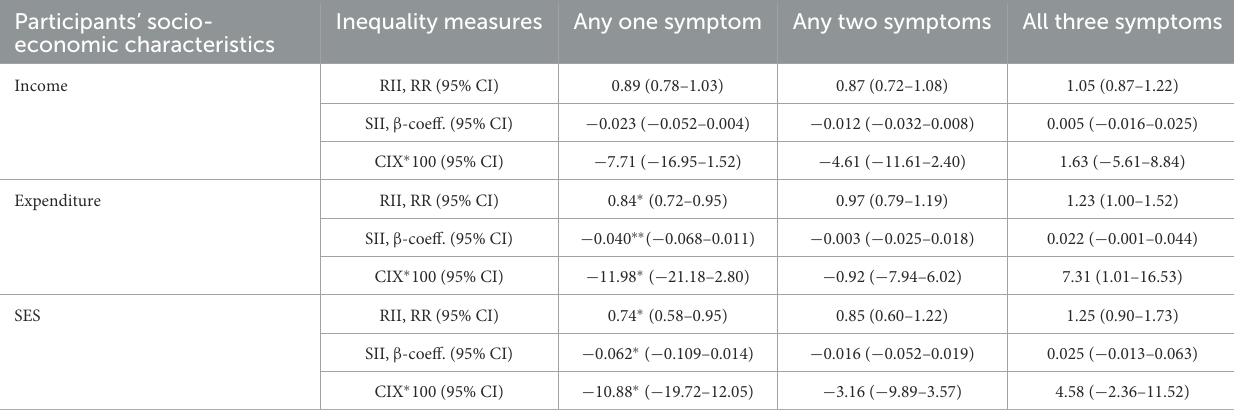
TABLE 4 Summary measures of income, expenditure and SES inequality in relation to coexistence of mental health-related symptoms ( n = 382). Participants’ socio- economic